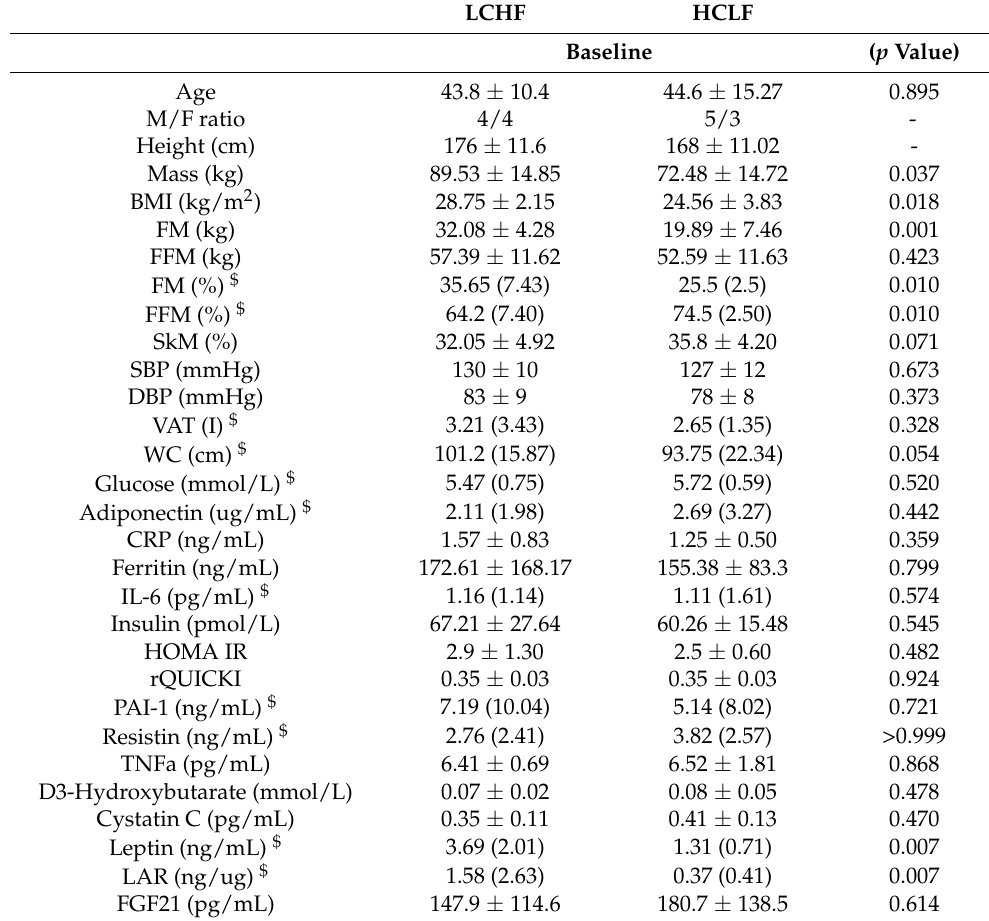
Table 1. Baseline differences between the LCHF ( n = 8) and HCLF ( n = 8)